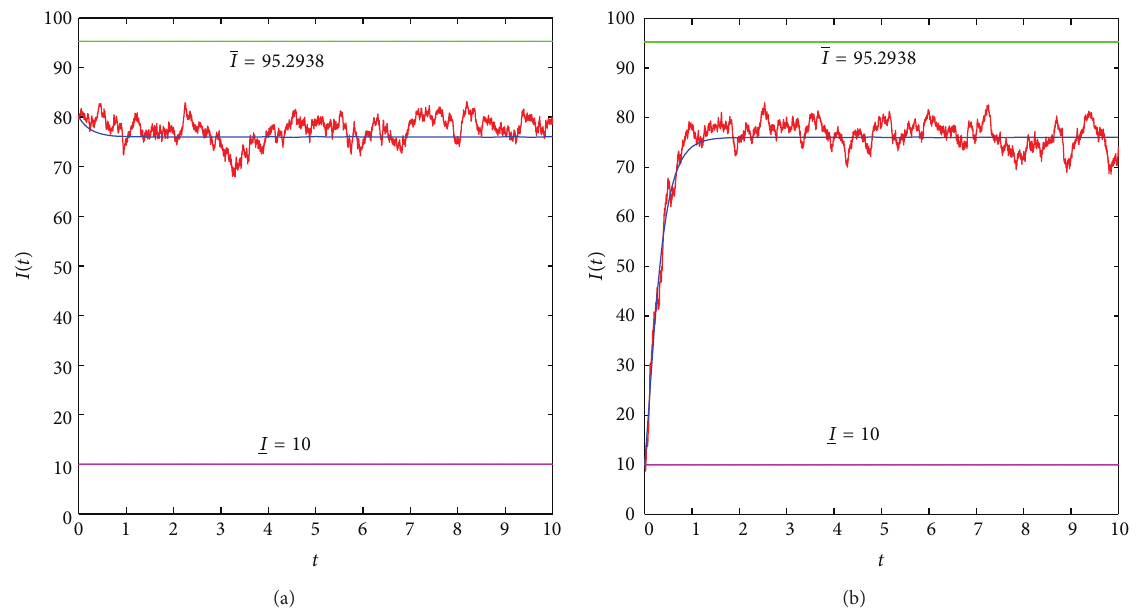
Figure 3: Computer simulations of 𝐼(𝑡) for model (5) (red line) and the deterministic model (1) (blue line), using the EM method with step size 0.001 and with initial values (a) 𝐼(0) = 80 and (b) 𝐼(0) = 10 . 𝐼 = 10 and 𝐼 = 95.2938 .